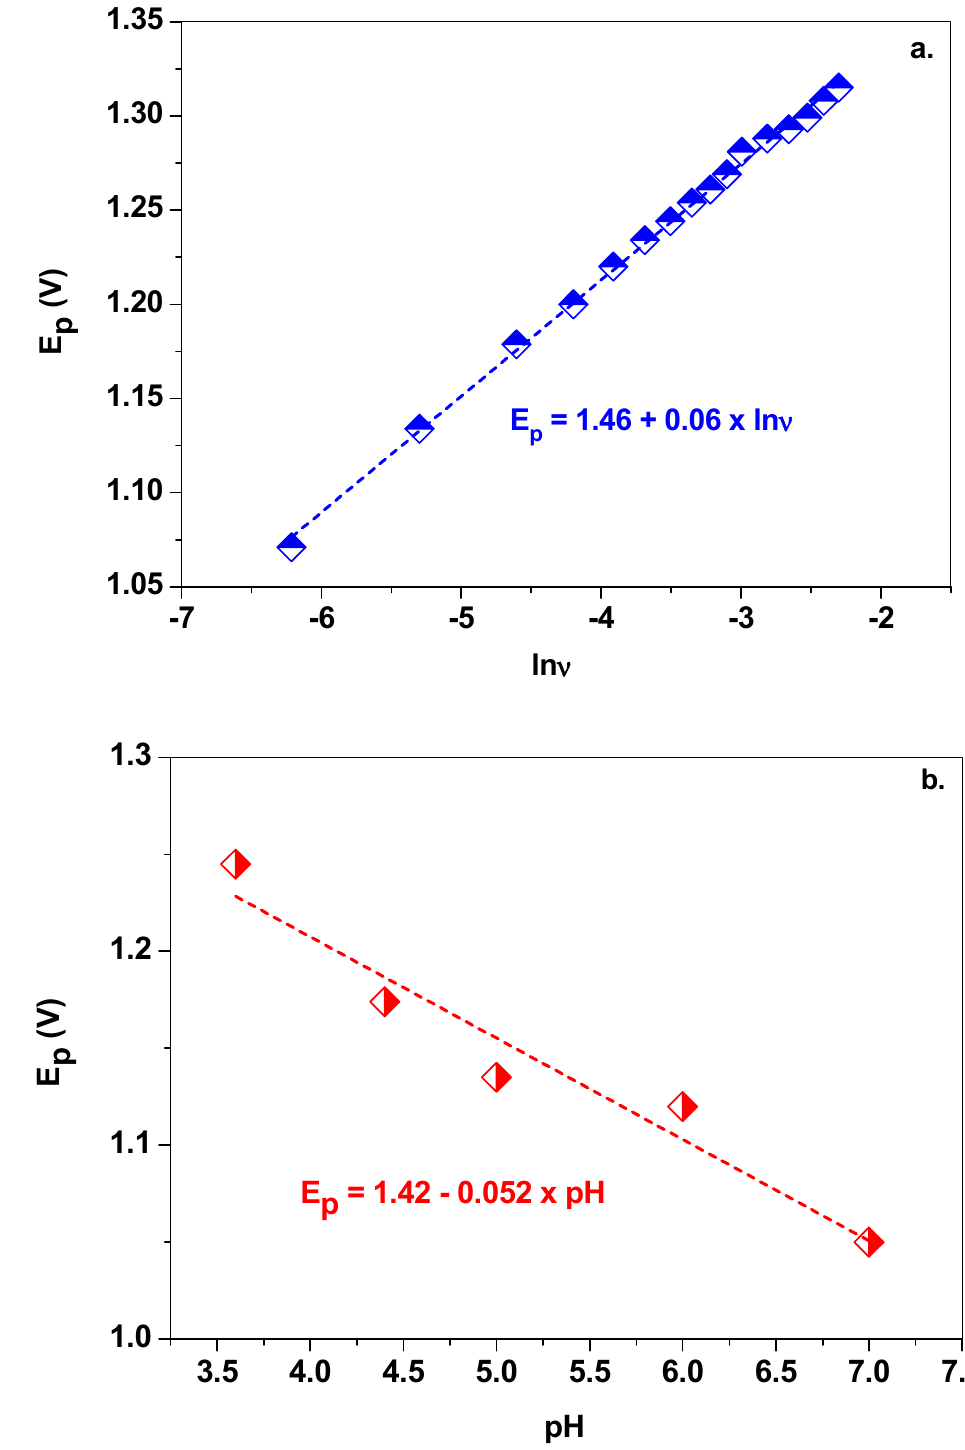
Figure 6. Dependence of peak potential, E p , versus the natural logarithm of scan rate, ln υ ( a ); dependence of E p versus the pH ( b ).